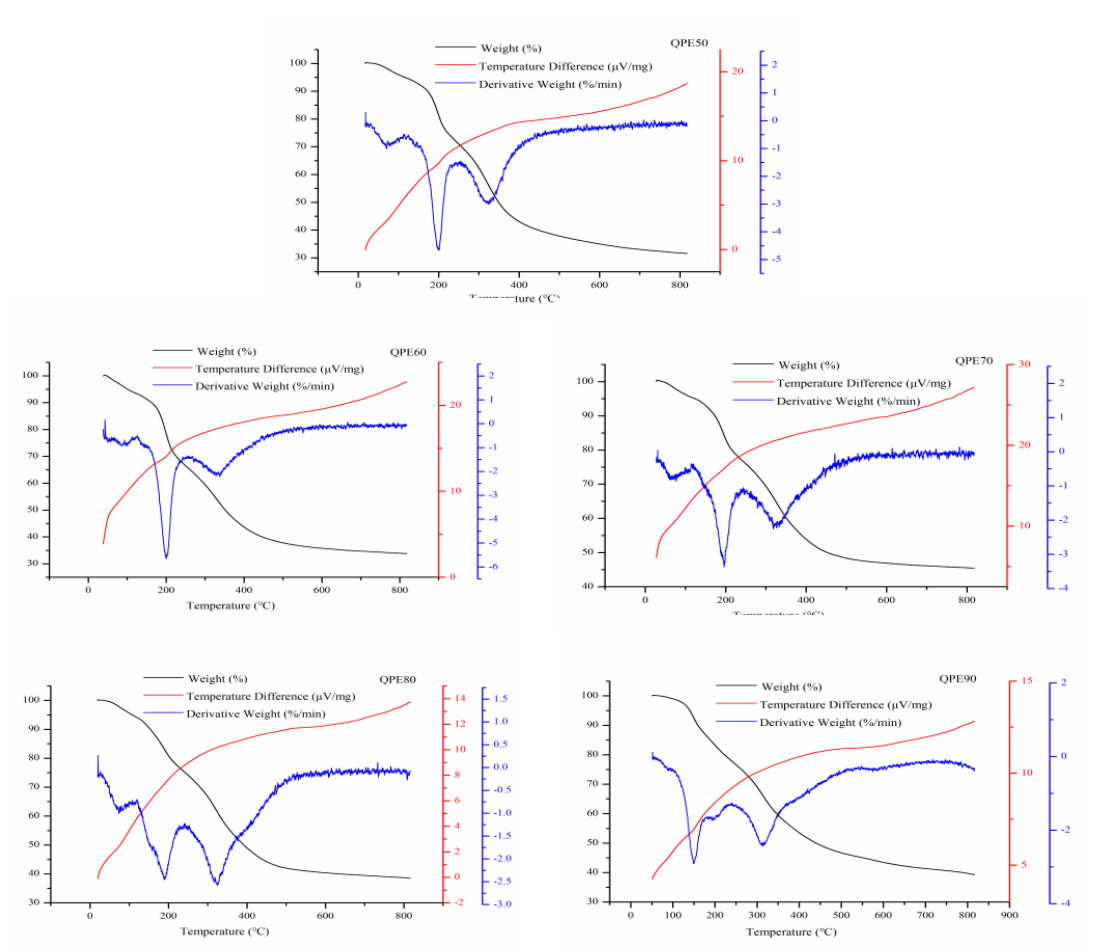
Figure 7. TG-DTA-DTG curves of QPs.